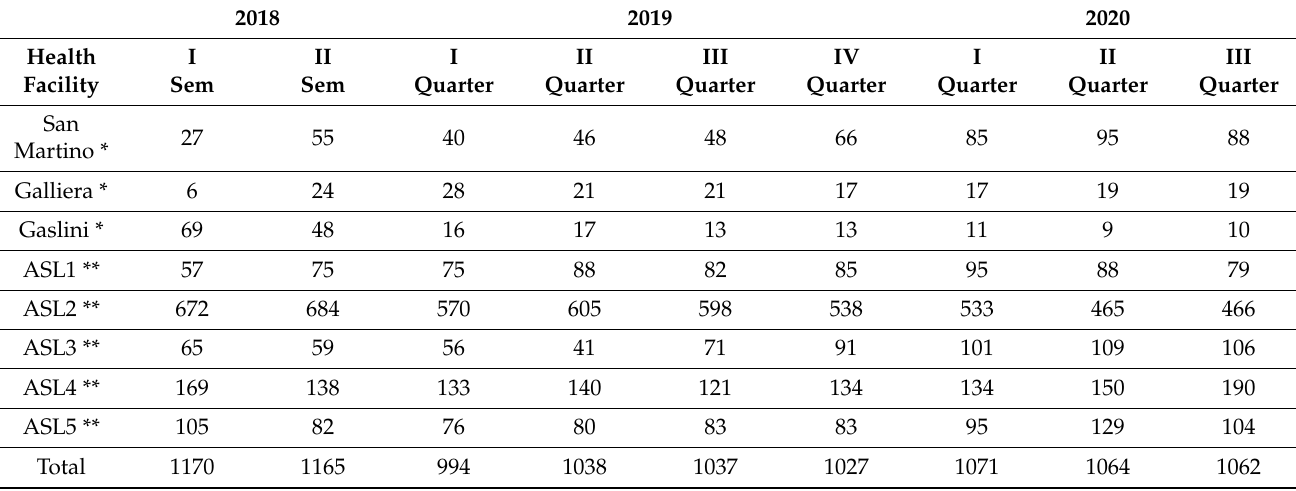
Table 2. Patients under treatment with medical cannabis from 2018 to